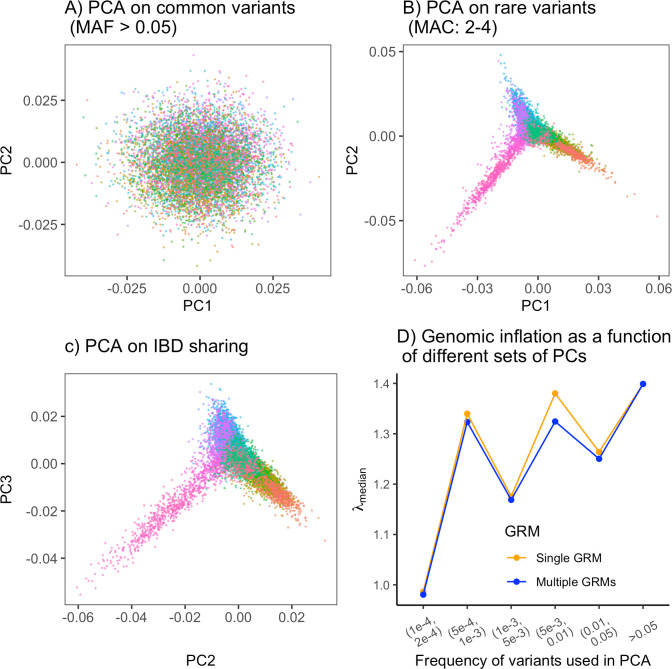
Example of how one might empirically minimize the inflation in test statistic in a genome-wide association study (GWAS) without knowledge of the demographic history.(A) Principal component analysis (PCA) on common variants shows little or no structure. PCA on (B) rare variants and (C) IBD-sharing captures population structure effectively. (D) Genomic inflation in summary statistics for GWAS on the non-heritable 'Smooth' phenotype as a function of frequency of variants used in PCA. Single genetic relatedness matrix (GRM; orange) refers to the inflation observed with PCs calculated using a single GRM constructed from variants in the given frequency bin. Multiple GRM (blue) refers to the inflation with two sets of PCs calculated separately: 50 PCs from common variants (MAF>0.05) and 50 PCs from variants in the given frequency bin. .